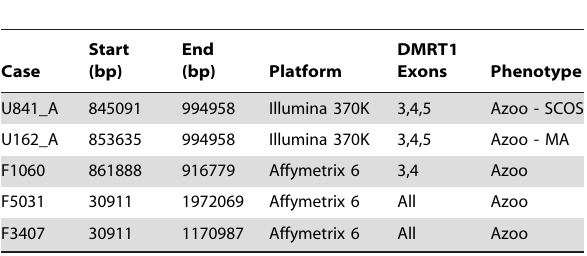
Table 4. DMRT1 deletions detected by array in the current